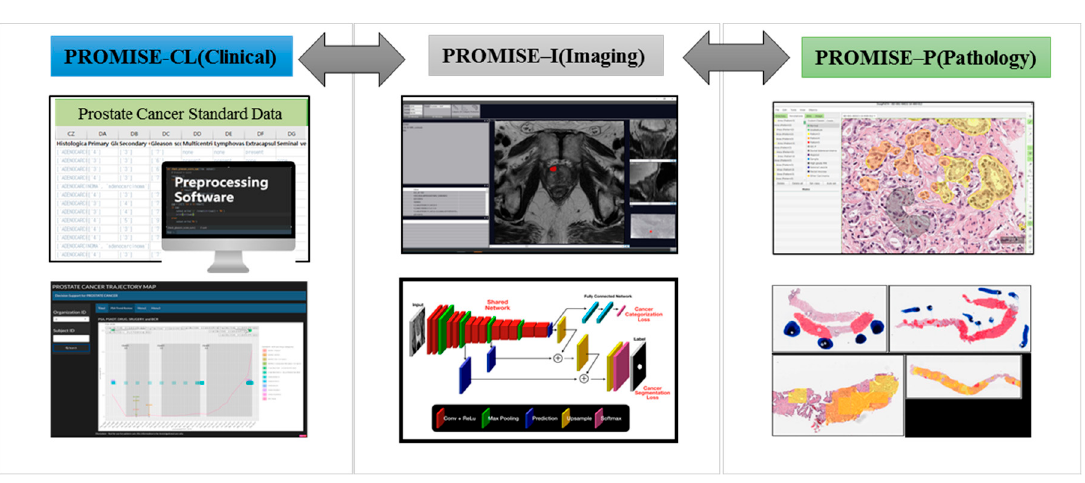
Figure 2. PROMISE CLIP Clinical, Imaging, and Pathology data.